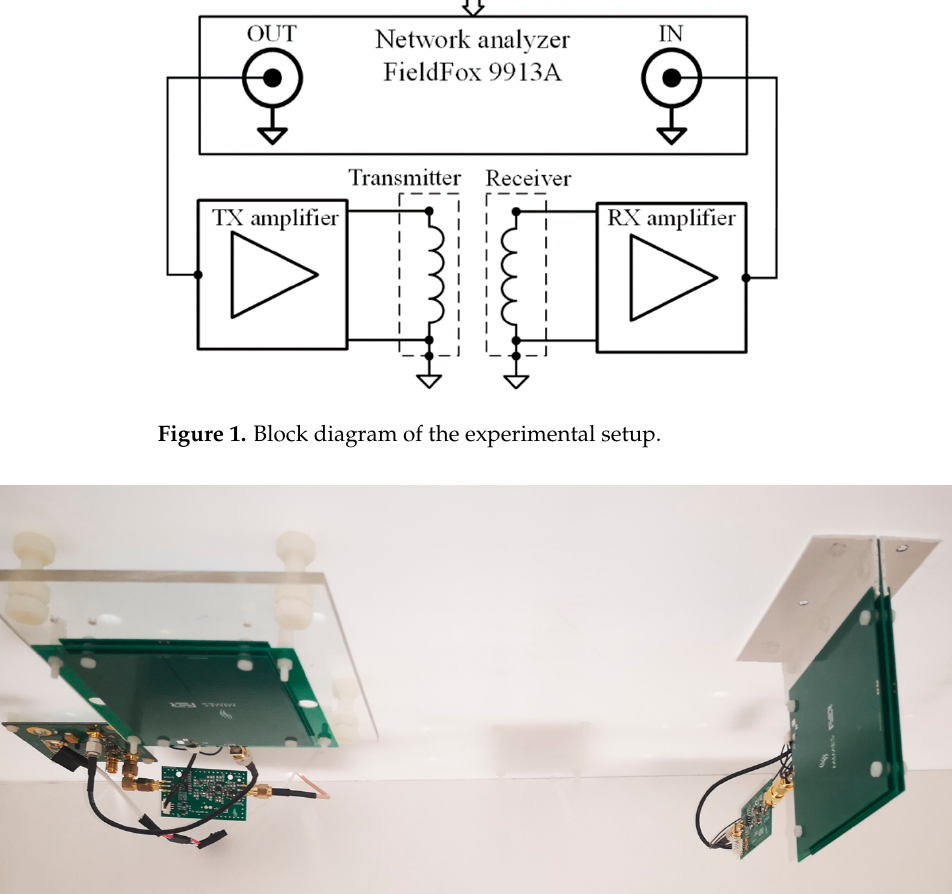
Figure 1. Block diagram of the experimental setup.